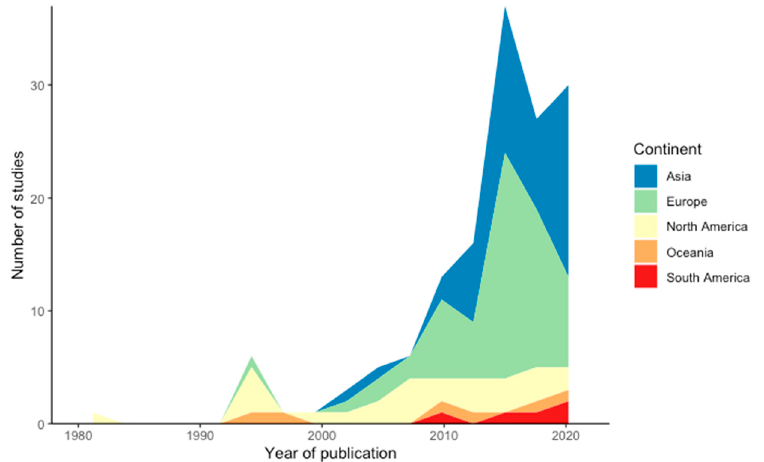
Figure 1. Number of studies in the systematic review dataset ( n = 147) published per continent, per year. Different coloured bands are cumulative within years and are stacked: thicker colour bands represent more cumulative publications for that continent in a given